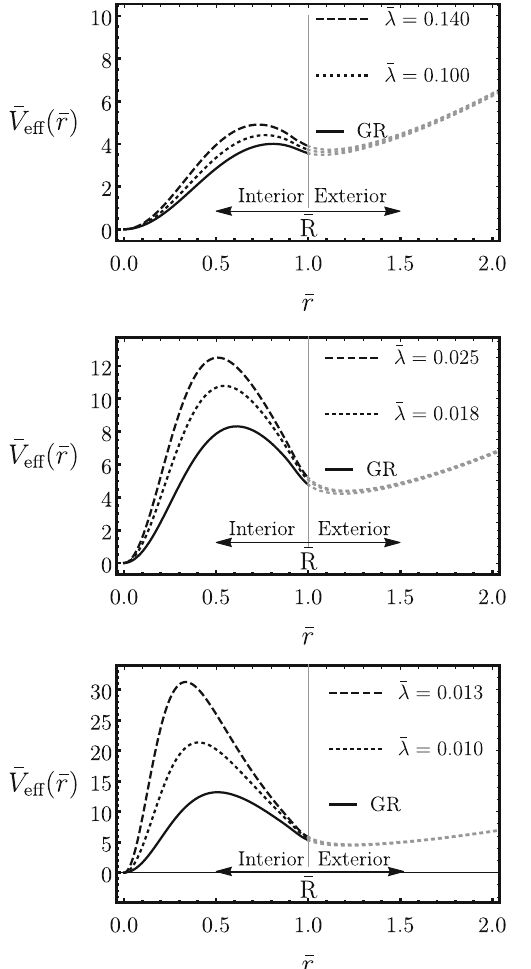
Fig. 12 V eff ( r ) for different values of ¯ ρ 0 and ¯ λ = 0 . 10 (upper panel), ¯ λ = 0 . 025 (center panel), ¯ λ = 0 . 013 (lower